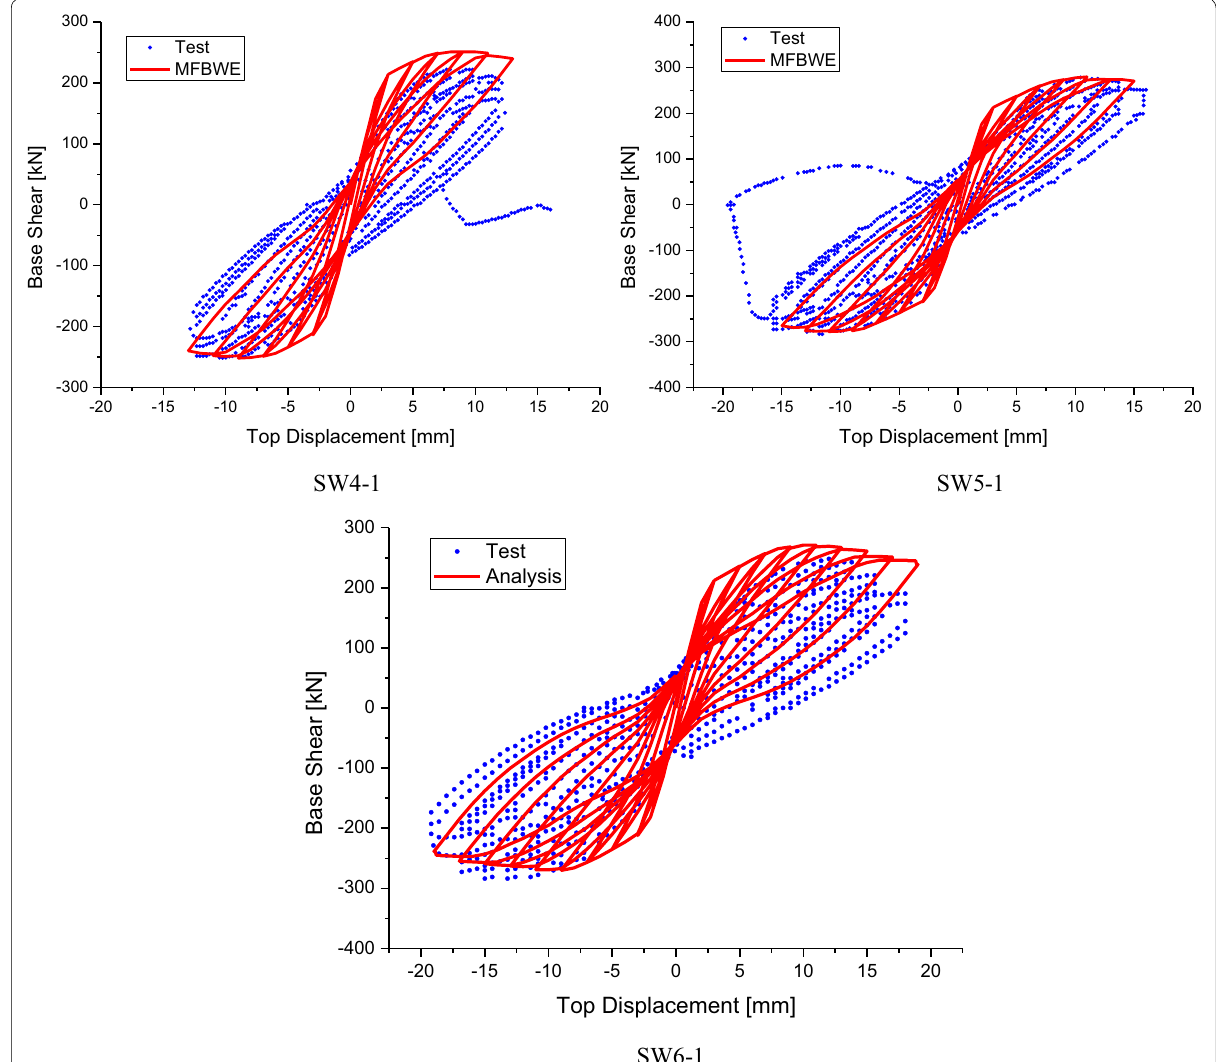
Fig. 12 Comparisons between the experimental data and the analytical results using the proposed